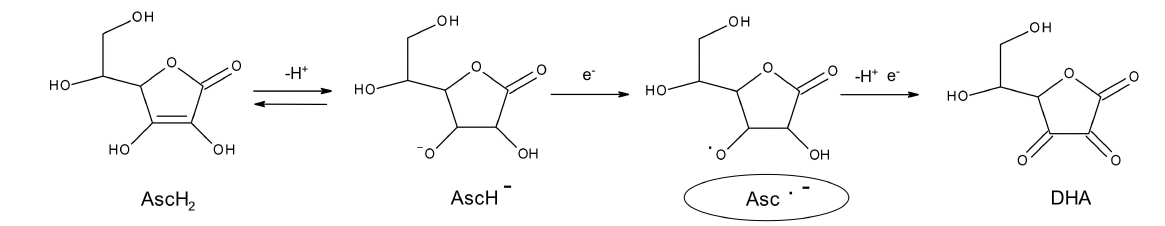
Figure 2. Ox-redox states of ascorbic